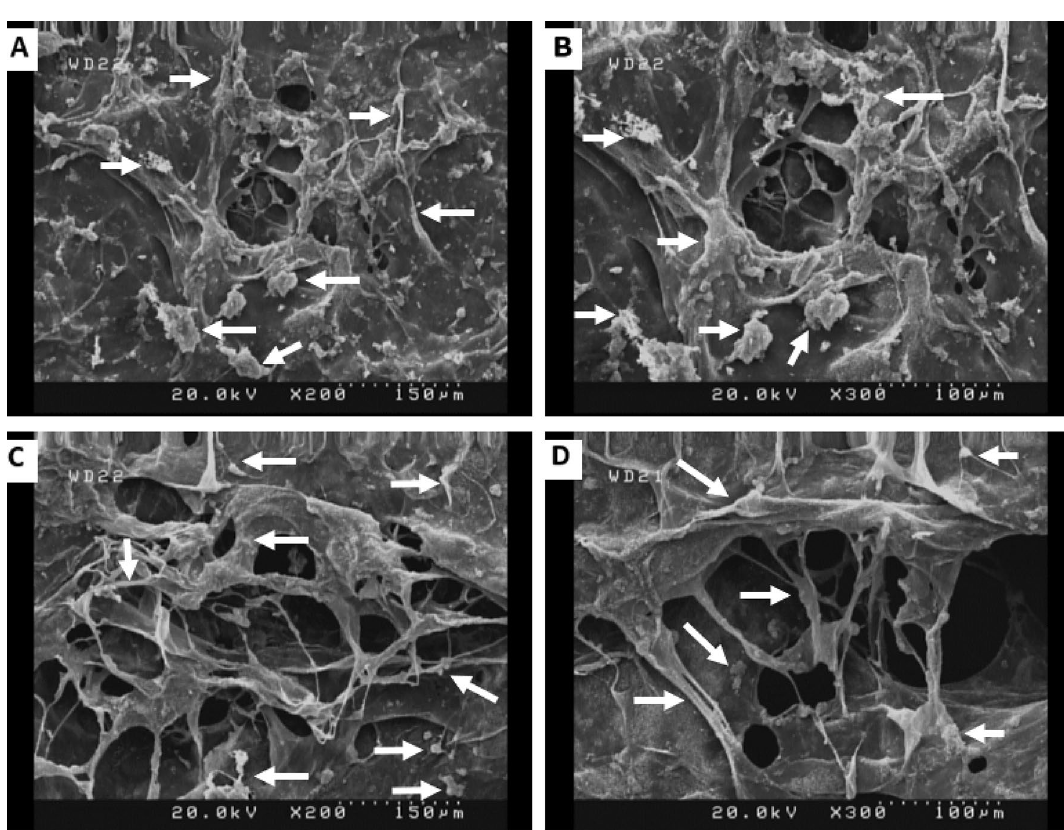
Figure 6. SEM images of hBMSCs seeded on Col ( A , B ) and Col-rGO ( C , D ) scaffolds after 48 h. Some cells are marked by